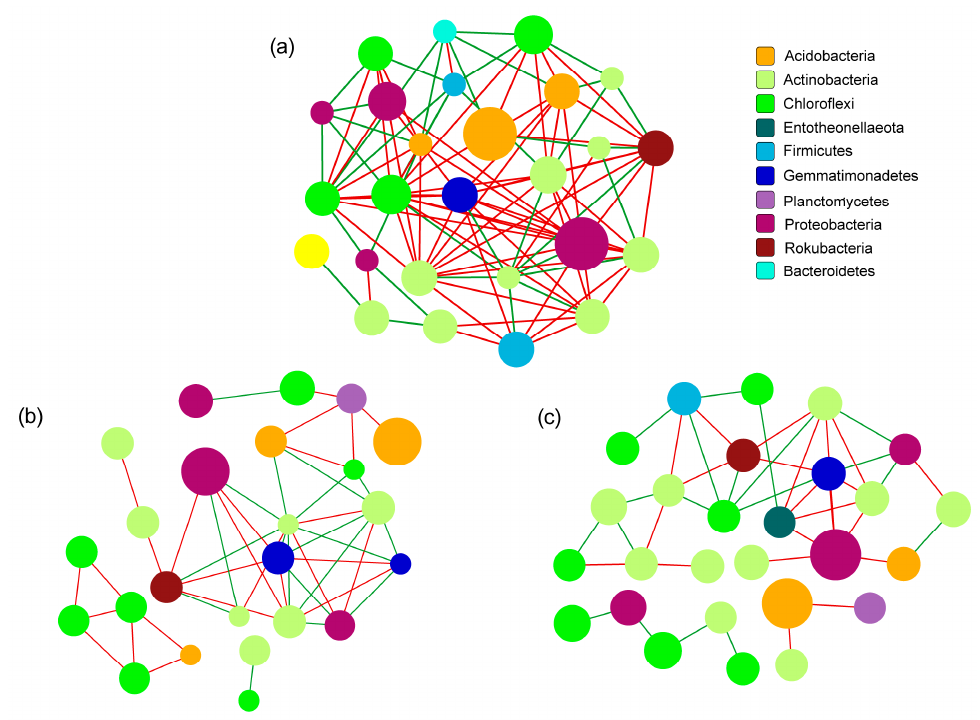
Figure 8. Correlation network analysis of microbial communities. Node color represents phylum classification. The size of the node is proportional to the richness of bacteria. Edge color corresponds to positive (red) and negative (green) correlation, and the edge thickness is equivalent to the correlation values. ( a ) The network between CK and B_BOF. ( b ) The network between CK and BOF. ( c ) The network between CK and FB.